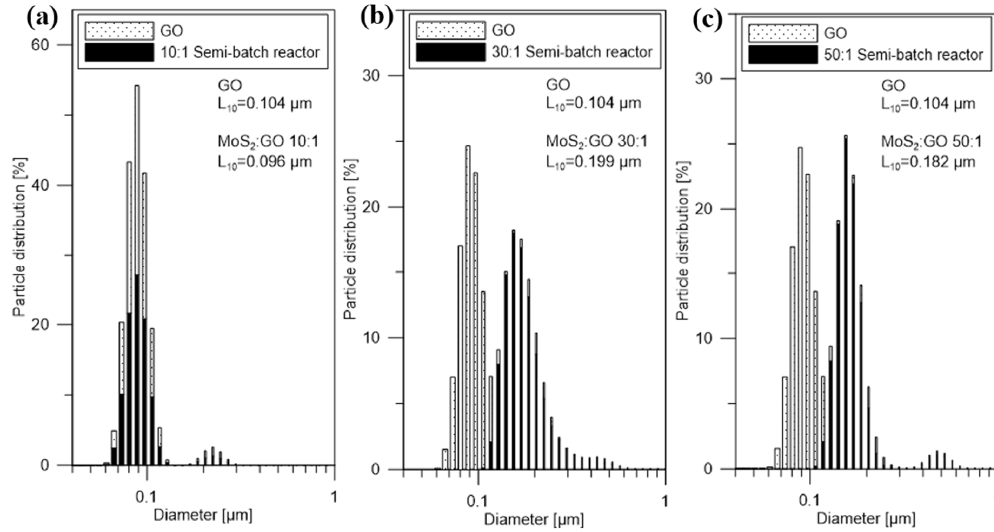
Figure 3. Particle size distribution profiles by number of particles of direct products of the reaction in the semi-batch system for MoS 2 / GO ratio ( a ) 10:1 ( b ) 30:1 ( c ) 50:1, and GO just before the reaction.